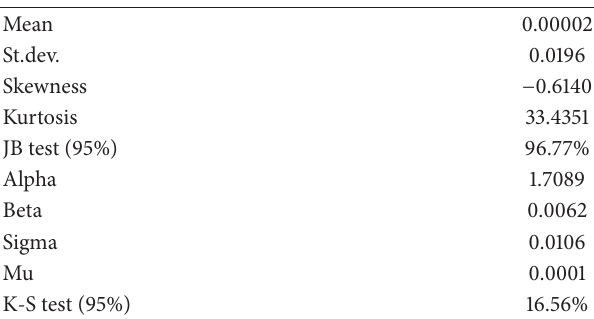
Table 1: Average of some statistics for the daily log-returns of the companies’ assets value obtained from the KMV-Merton